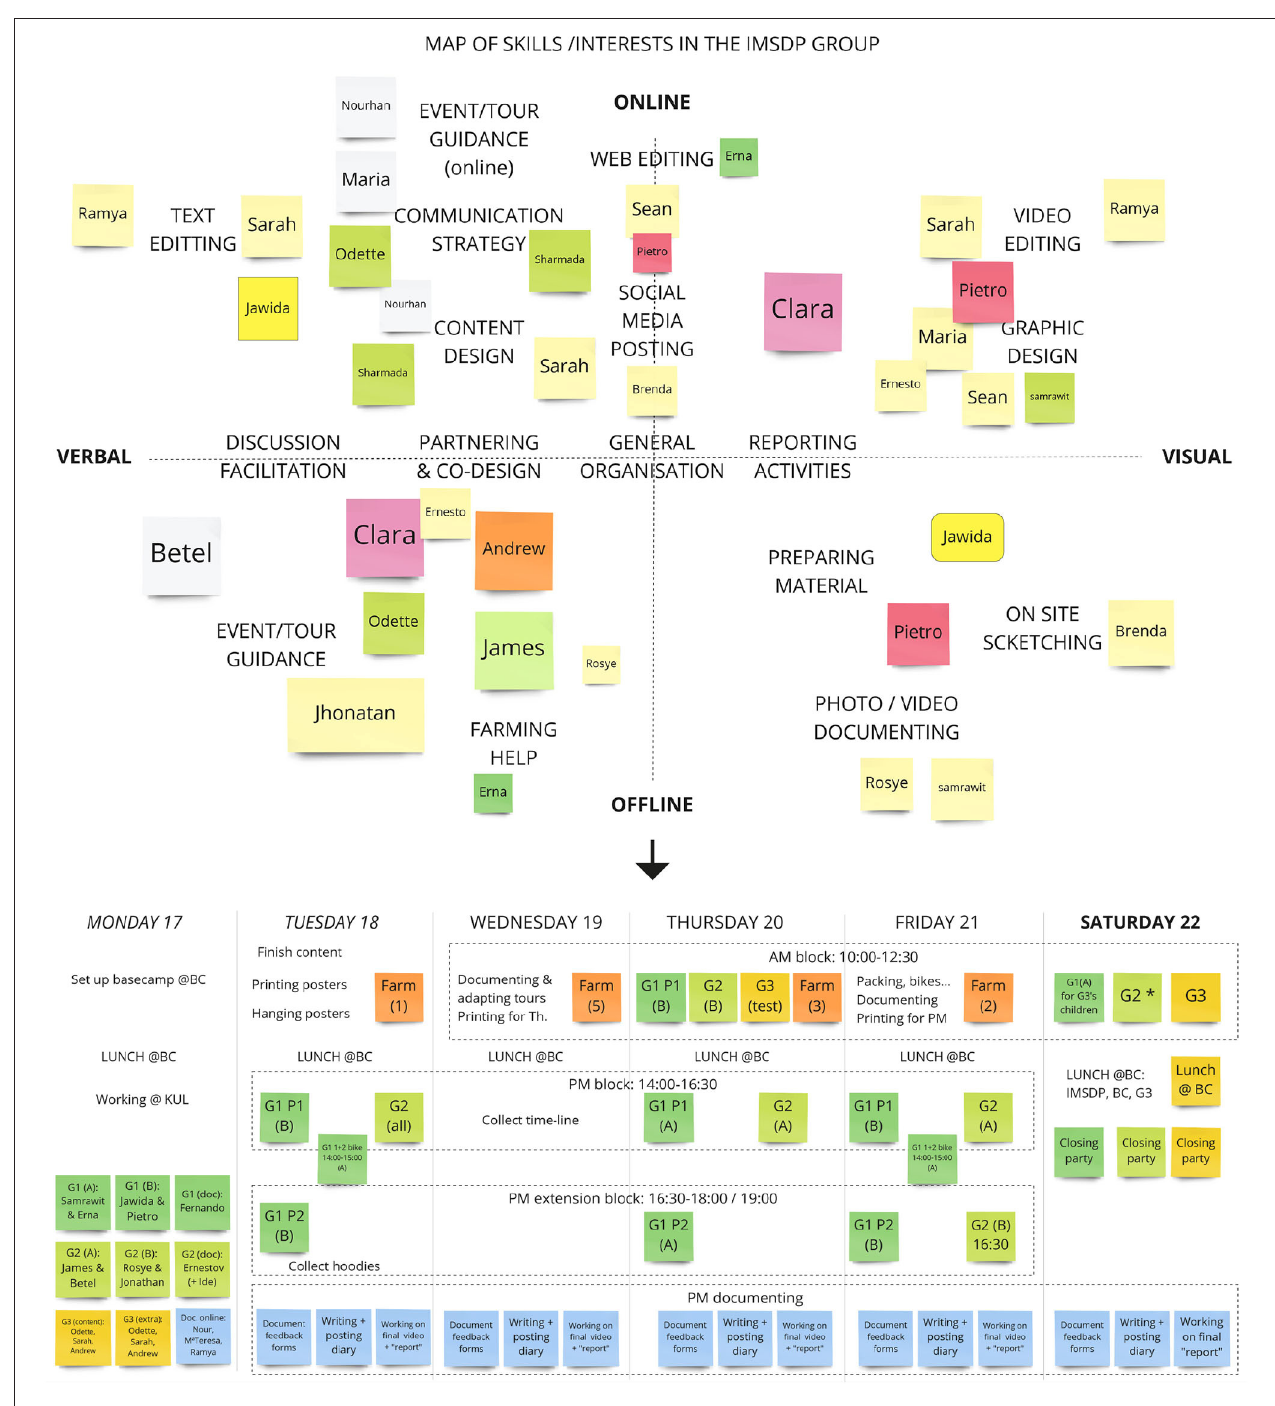
FIGURE 7 | Screenshot from the IMSDP Miro board negotiating the reorganization of working teams as per required tasks and personal skills and interests and the organization of work during the workshop